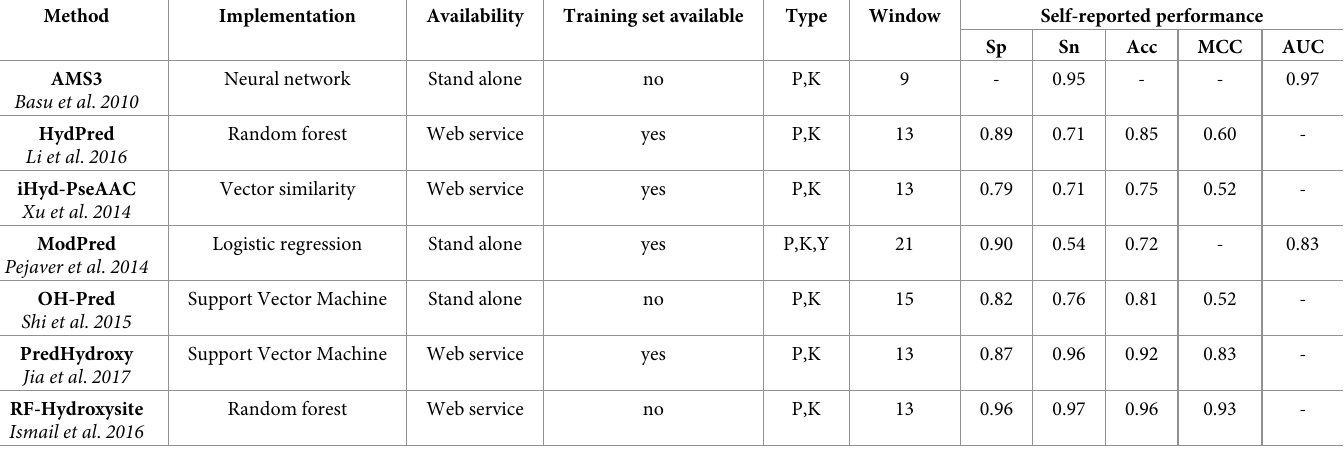
Table 2. Methods overview. Self-reported performance is taken from the corresponding method publications preferring values reported from independent validation sets, i.e. not used in the training. The “Type” column indicates the type of hydroxylated residue predicted, proline (P), lysine (K) and tyrosine (Y). “Window” indicates the number or neighbour residues considered for a prediction. Self-reported performance includes specificity (Sp), sensitivity (Sn), accuracy (acc), Matthew’s Correlation Coefficient (MCC) and the area under the ROC curve